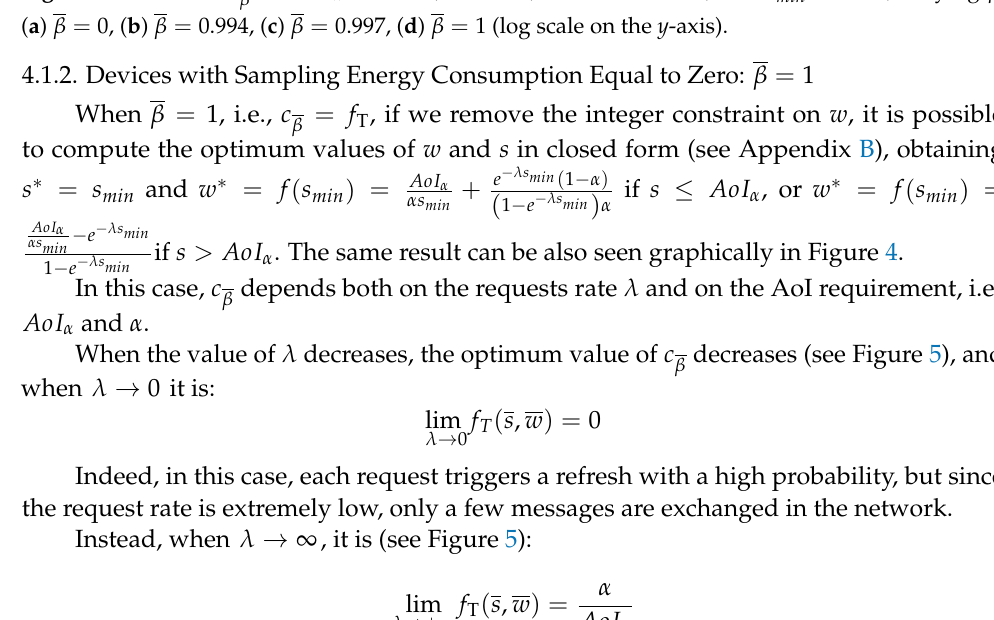
= 60 s, varying β : min